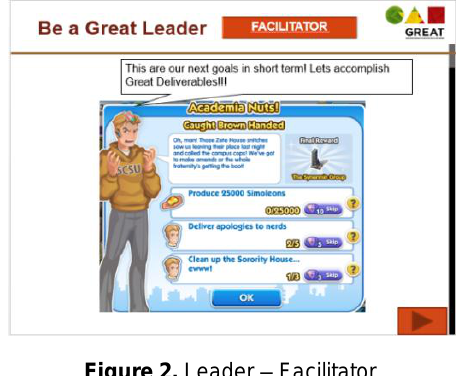
Figure 2. Leader – Facilitator